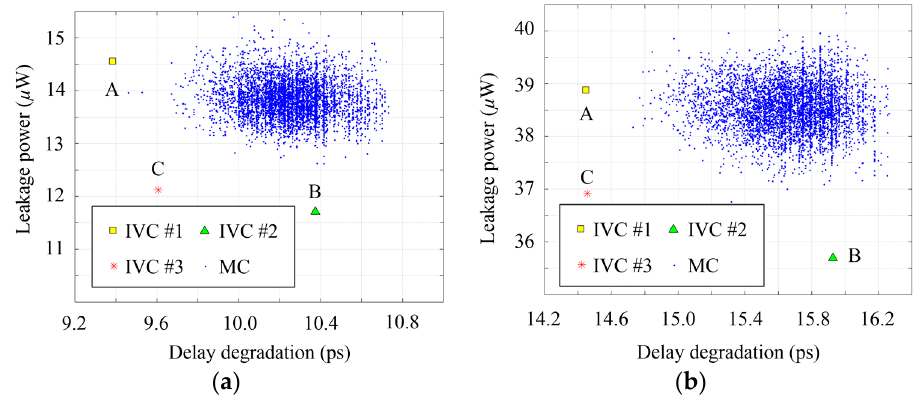
Figure 6. Degradation and leakage minimization result by different ILP formulations. ( a ) c880 circuit; ( b ) c3540 circuit.